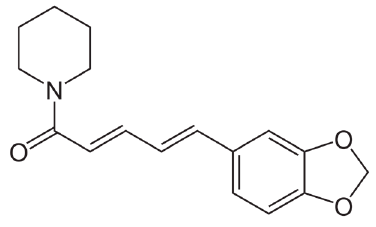
Figure 1. Chemical structure of piperine.